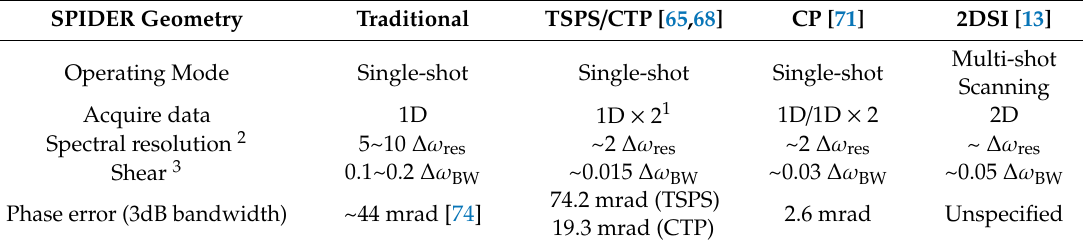
Table 2. Comparison of some SPIDER geometries. SPIDER